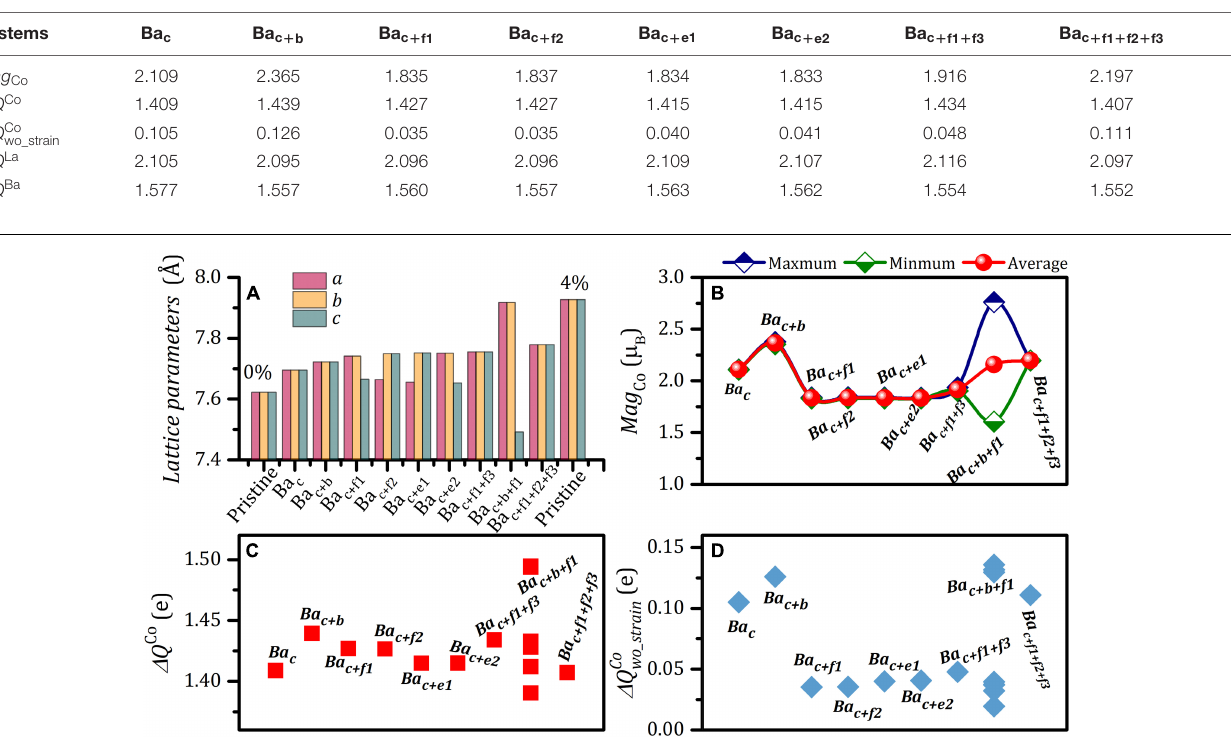
TABLE 2 | The magnetic moment localized at Co atom, Mag Co in µ B , charge transfer of Co atom, (cid:49) Q Co , (cid:49) Q Co wo_strain in e , and the charge transfer of La and Ba atom, (cid:49) Q La , (cid:49) Q Ba in e , for Ba c , Ba c + b , Ba c + f1 , Ba c + f2 , Ba c + e1 , Ba c + e2 , Ba c + f1 + f3 , and Ba c + f1 + f2 + f3 defective systems ( (cid:49) Q Co defective LaCoO 3 due to the difference of electronic configuration between Ba and La).